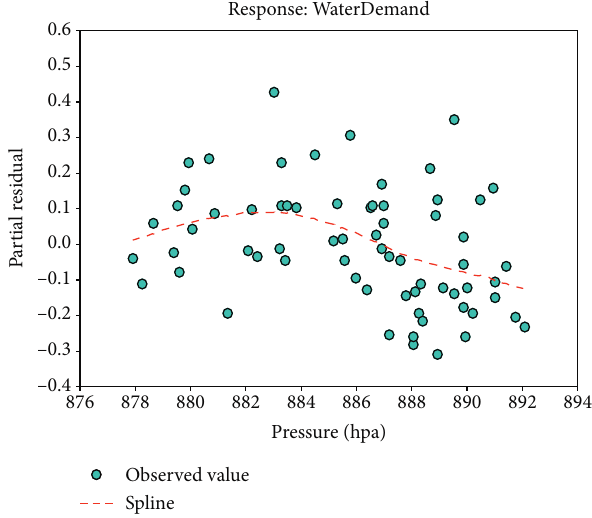
Figure 5: The individual response of the water consumption to pressure.